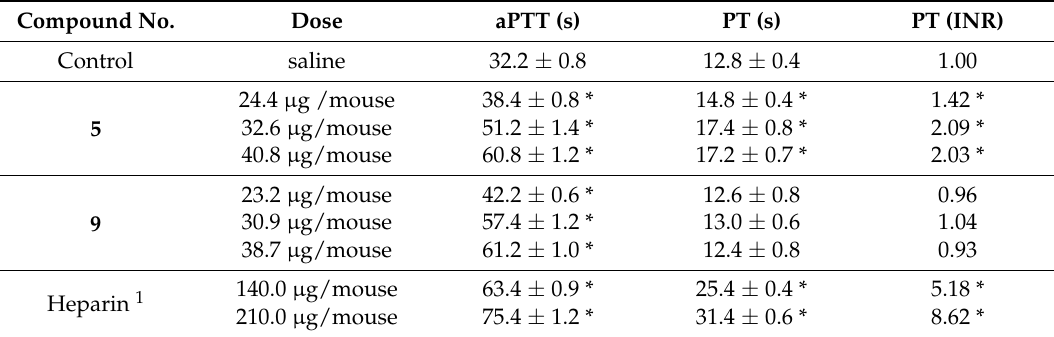
Table 4. Ex vivo clotting time of 5 and 9 .